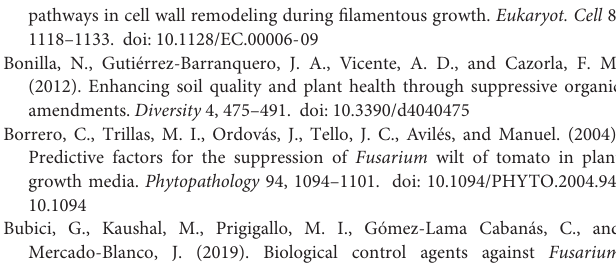
Supplementary Figure 2 | Genome-wide identification and the potential function analysis of the beneficial TpQ2. Supplementary Figure 3 | Single and co-culture of TpQ2 and Fom. Supplementary Figure 4 | MA map analysis (A) , Gene Ontology analysis (B) , and KEGG enrichment analysis (C) using DEGs identified between the Fom and TpQ2+Fom treatments. Supplementary Figure 5 | Domains predicted in FomCFEM , phylogenetic tree, and PCR screen of Fom FomCFEM deletion and complementation mutants. Supplementary Figure 6 | Prediction of GPI site in FomCFEM . Supplementary Figure 7 | A schematic diagram showing detection of FomCEFM deletion mutants. Supplementary Figure 8 | Influences of TpQ2 on microbial alpha diversity index and community composition. Supplementary Figure 9 | Network level microbial features in the co-occurrence networks. Supplementary Figure 10 | Co-occurrence networks of soil microbial communities. Supplementary Table 1 | Disease incidence of Fusarium wilt of bitter gourd in field after transplantation for 45 days at 2015-2019. Supplementary Table 2 | The primers and type strains used in identification of strain TpQ2. Supplementary Table 3 | Solid fermentation formula of strain TpQ2. Supplementary Table 4 | The primers used in the function identification of FomCFEM . Supplementary Table 5 | The primer of DEGs used in the RT-qPCR. Supplementary Table 6 | The control efficacy of biocontrol agents on Fusarium wilt of bitter gourd. Supplementary Table 7 | Inhibition of strain TpQ2 against pathogenic fungi. Supplementary Table 8 | The colony diameter of strain TpQ2 on different medium. Supplementary Table 9 | The genomic information of strain TpQ2. Supplementary Table 10 | The data quality of RNA-seq. Supplementary Table 11 | The expression patterns of cell cycle and cell wall biosynthesis associated genes. Supplementary Table 12 | Response of soil chemical properties and soil enzyme activity to invasion of Fom and TpQ2. Supplementary Table 13 | Spearman’s correlation analysis to explain the correlation of key microorganisms, alpha diversity, and exogenous microorganisms. Supplementary Table 14 | Key topological features of soil microbial